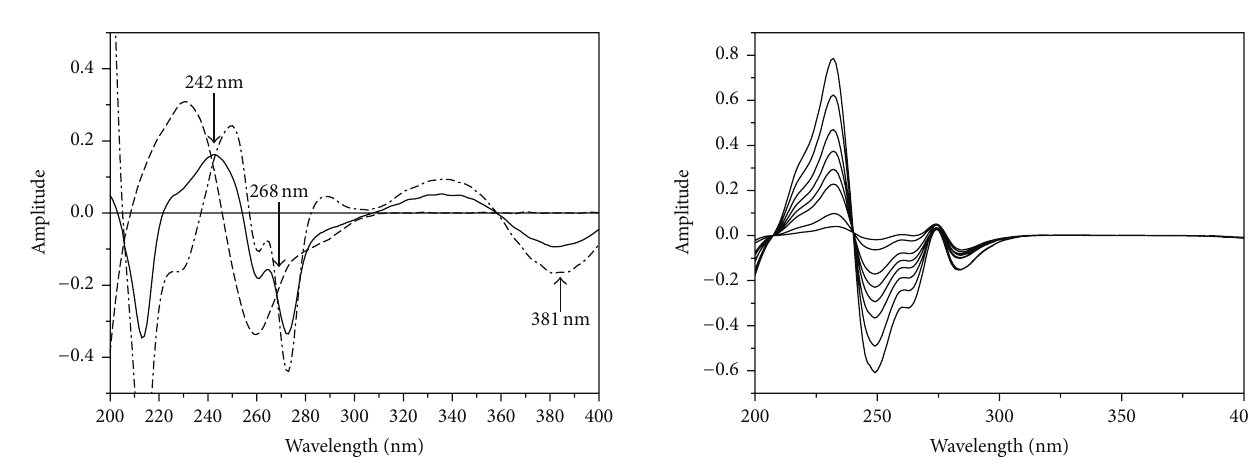
Figure 6: First derivative spectra of 8 𝜇 g/mL AA (-----), 8 𝜇 g/mL RU (- ⋅ - ⋅ - ⋅ -), and a mixture of 4 𝜇 g/mL AA with 4 𝜇 g/mL RU (—) using methanol as blank.